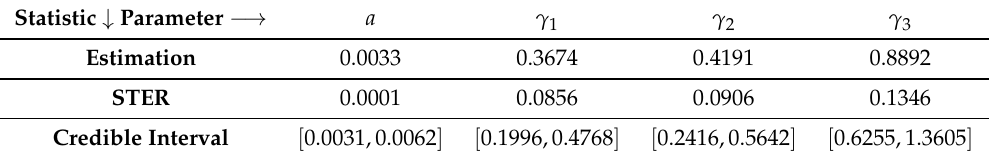
Table 14. The BSEs for the BBXEx distribution using data set